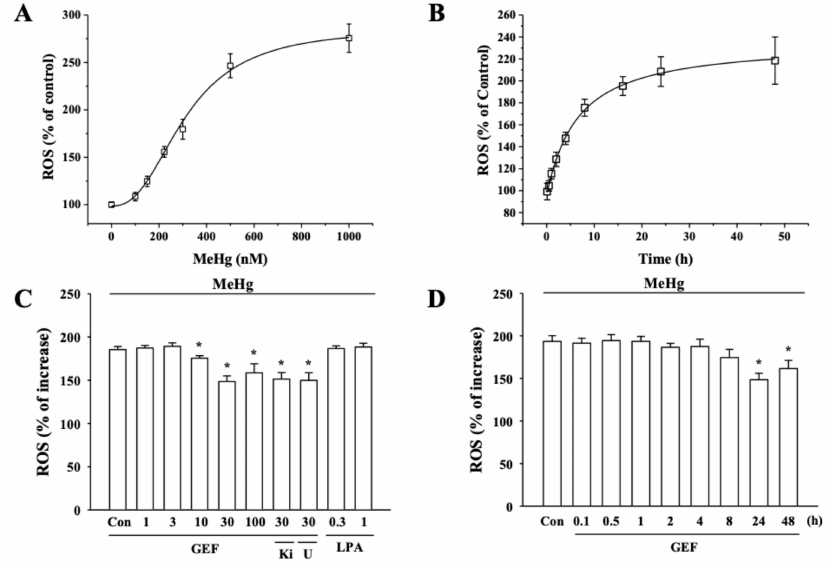
Figure 3. E ff ects of MeHg in intracellular reactive oxygen species (ROS) formation and e ff ects of GEF on MeHg-induced ROS generation. ( A ) MeHg induces ROS in a concentration-dependent manner. MeHg was treated for 24 h. ( B ) MeHg-mediated ROS generation was time-dependent. ( C ) E ff ects of GEF on the increase of MeHg-induced ROS generation. hNPCs were incubated MeHg with the control vehicle (Control) or various concentrations of GEF. GEF decreased ROS generation in a concentration-dependent manner. The indicated concentration of GEF was pretreated 24 h before MeHg (350 nM). LPA1 / 3 receptor antagonist (Ki16425, 10 µ M) and phospholipase C inhibitor (U73122, 5 µ M) was used. ( D ) GEF-mediated ROS decrease was time-dependent. Cells were treated with 30 µ g / ml GEF and subjected to WST-1 assay as described in the Materials and Methods section. Data are presented as the mean ± SEM (n = 9; * p < 0.01, compared with untreated